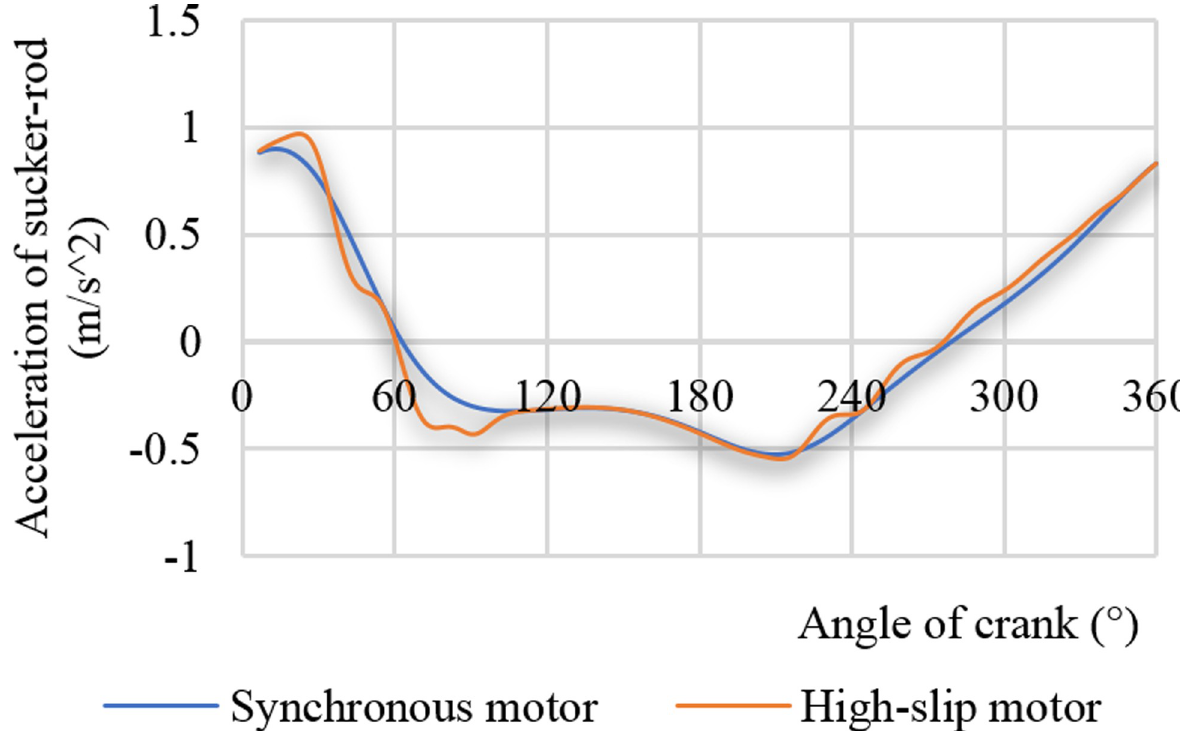
Fig 7. Acceleration curves of the sucker